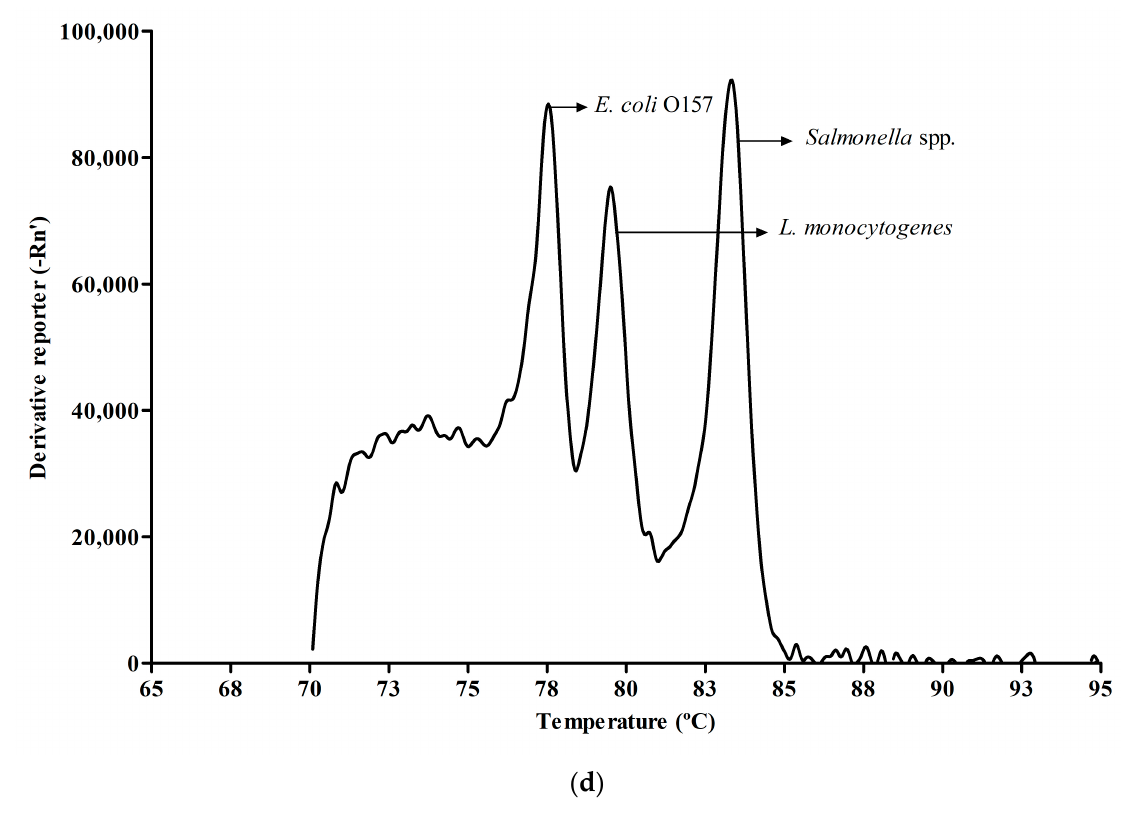
Figure 2. Predicted melting curves generated by uMELT online software in simplex ( a ) and multiplex ( b ) reaction and experimental melting curves obtained by pure culture in simplex ( c ) and by sample analysis in multiplex ( d ).